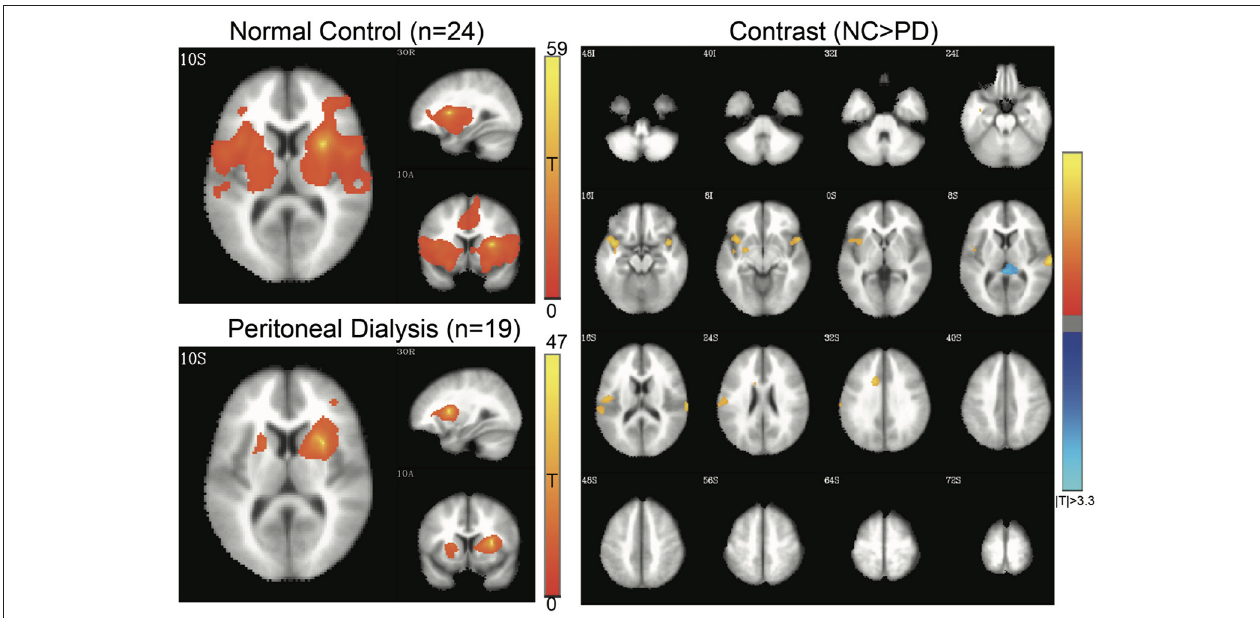
FIGURE 4 | Salience network (SN) of controls and patients with PD. Connectivity map of either group is shown at the left side (FWE-corrected p < 0.05), and the contrast map at the right side (3dClustSim-corrected p < 0.05). In the contrast map, the orange color represents significantly increased connectivity in controls, including temporal gyrus, cingulate gyrus, and postcentral gyrus, whereas the blue color represents decreased connectivity in controls, mainly in the thalamus. PD, peritoneal dialysis; NC, normal controls.